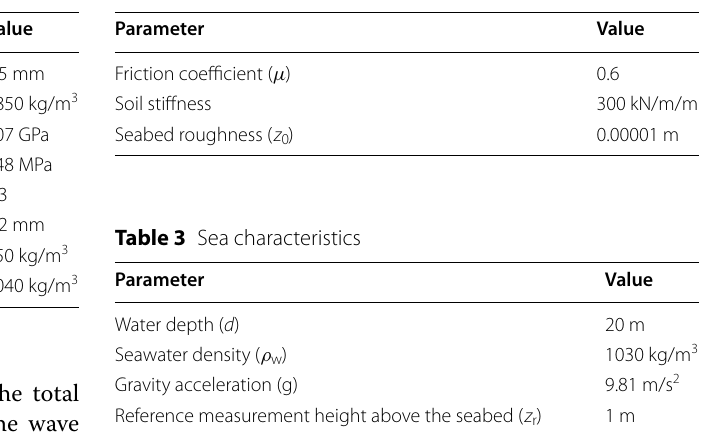
Table 1 Pipeline data and material properties Table 2 Soil parameters